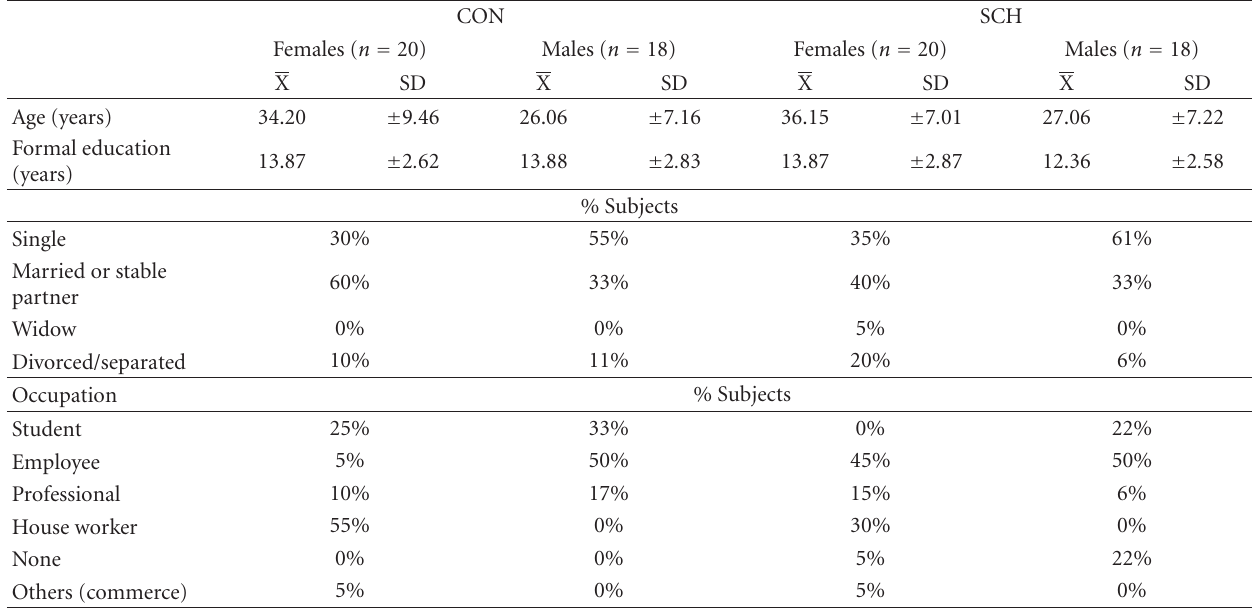
Table 1: Sociodemographic characteristics from healthy controls (CON) and schizophrenic patients (SCH).